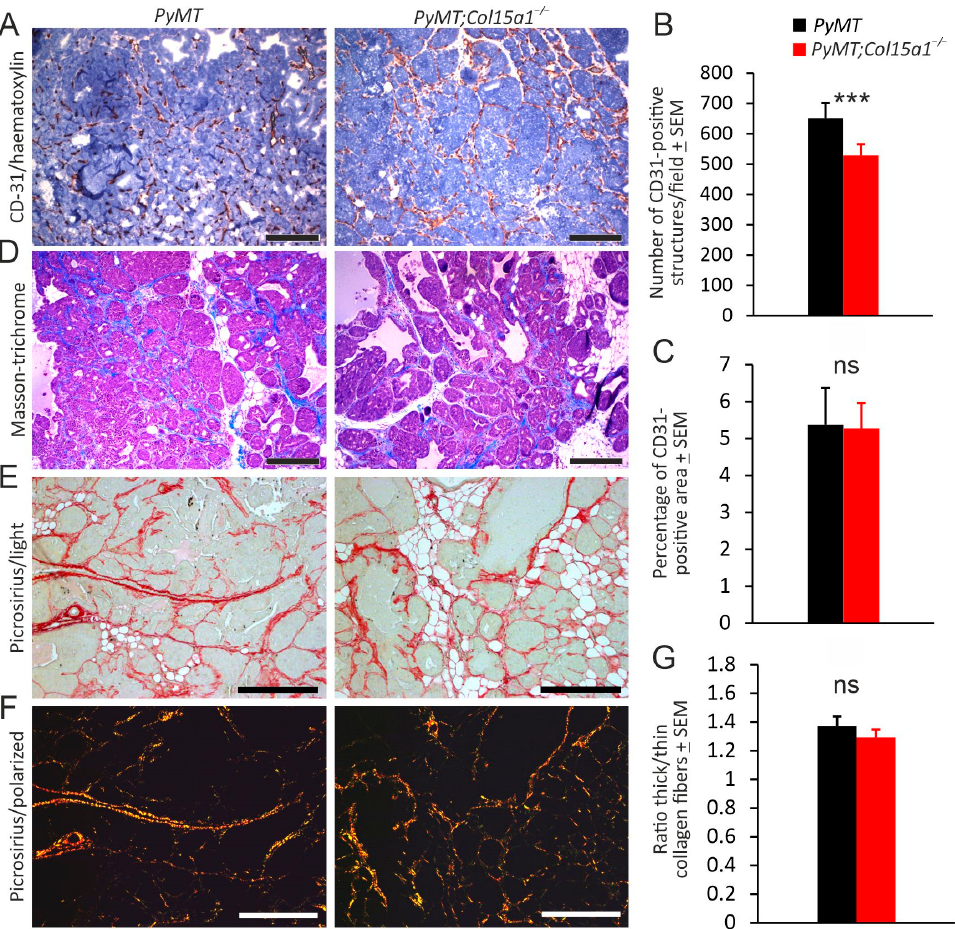
Figure 2. Angiogenesis and fibrosis in MMTV-PyMT mammary tumours. ( A ) Immunohistochemistry for CD-31 (red) in tumours of 12-week-old control PyMT and PyMT;Col15a1 ‒ / ‒ mice. ( B ) Manual counting of CD-31-positive structures in tumours. For both genotypes ( n = 9), four random microscopic fields were analysed at 100× magnification. ( C ) ImageJ analysis of CD-31-positive areas in the same microscopic fields. Quantification of the signal in the light microscopy images of tumour samples stained with Masson’s trichrome ( D ) and picrosirius red ( E ) revealed comparable fibrillar collagen content in the control and PyMT;Col15a1 ‒ / ‒ tumours. ( F , G ) Quantification of the birefringence of picrosirius red signals captured under polarised light showed a slightly reduced ratio of thick (red) to thin (green) collagen fibres in the PyMT;Col15a1 ‒ / ‒ tumours in comparison to the PyMT control tumours. Samples were collected from mice at 10–14 weeks of age (N = 8 mice for both genotypes; one tumour sample per mouse was analysed). Four microscopic fields per tumour at 100× magnification were analysed. Scale bars in ( A , D – F ), 200 µm. Error bars in ( B , C , G ) indicate s.e.m. *** p < 0.001; ns, not significant.